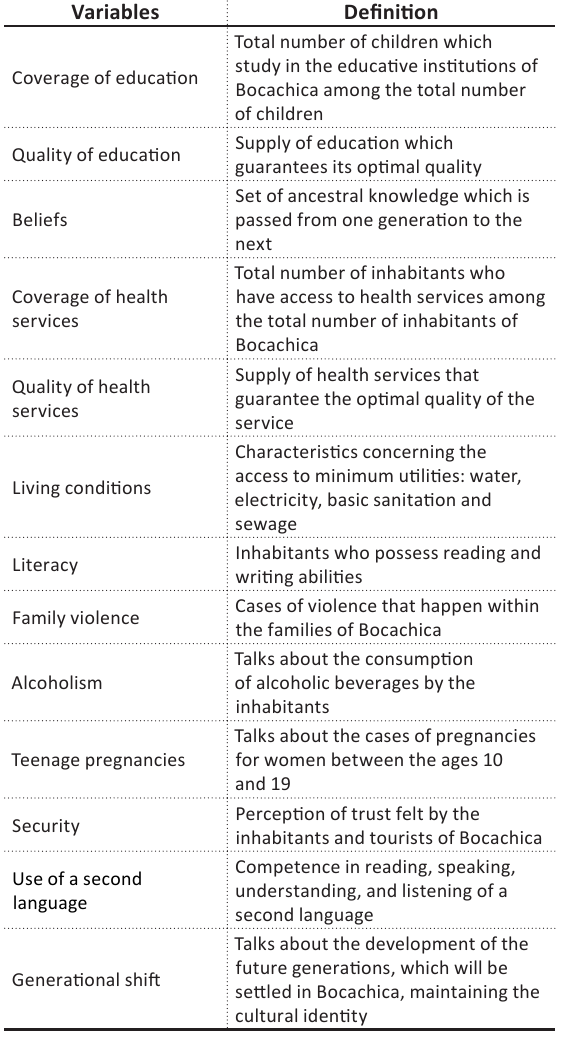
Table 4. Technological dimension